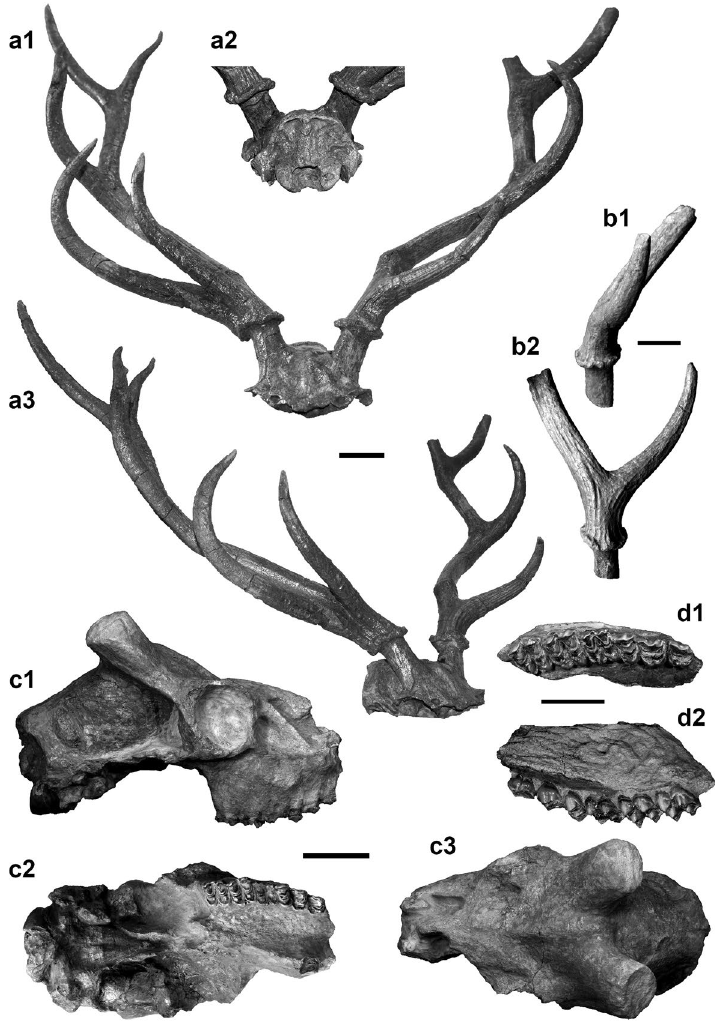
Figure 1. Selected cranial remains of ‘Pseudodama’ nestii from Pantalla (Italy). ( a ) Cranium SABAP_UMB 337655 in rostral ( a1 ), caudal ( a2 ), and rostro-lateral ( a3 ) views. ( b ) Left pedicle with basal fragment of antler SABAP_UMB 337625 in rostral ( b1 ) and medial ( b2 ) views. ( c ) Cranium SABAP_UMB 337643 in right lateral ( c1 ), ventral ( c2 ), and dorsal ( c2 ) views. ( d ) Maxillary fragment SABAP_UMB 337633 in occlusal ( d1 ) and lingual ( d2 ) views. Scale bars: 3